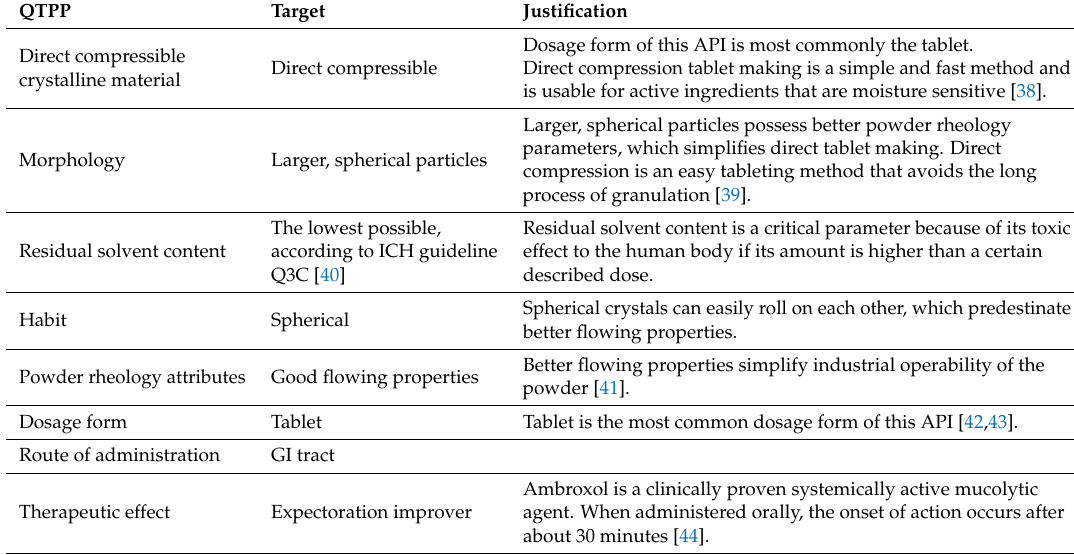
Table 2. Quality target product profiles (QTPPs) of the spherical ambroxol hydrochloride (AMB HCl) produced by the spherical agglomeration (SA) method.